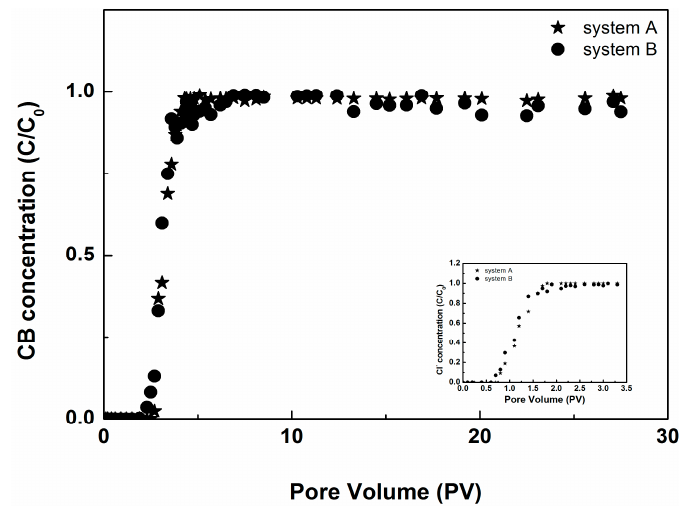
Figure 5. Variations in CB concentration profiles over times for column one of both systems. The inset displays the breakthrough curve of a sodium chloride (NaCl) tracer.